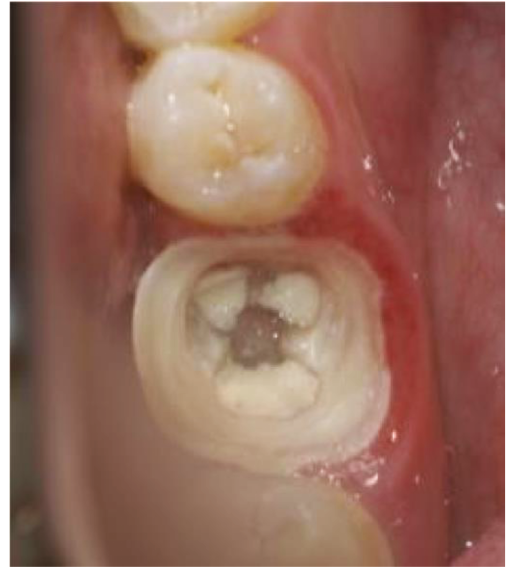
Figure 5: Lining the root canal entrances with glass ionomer cement.